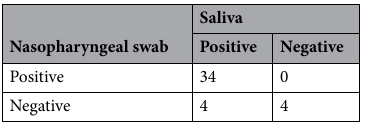
Table 1. Detection summary of SARS-CoV-2 (N = 42).